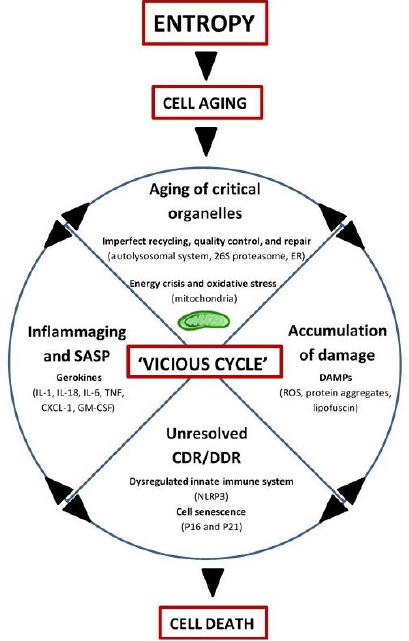
Figure 2. Integrated Systems Hypothesis of Aging (see text for details). DAMPs: danger-associated molecular patterns; ER: endoplasmic reticulum; CDR: cell danger response; DDR: DNA danger response; Inflammaging: chronic, low-grade inflammation with aging; SASP: senescence-associated secretory phenotype; Gerokines: cytokines, chemokines, growth factors, and proteases increased with aging; Vicious cycle: self-reinforcing feedback loop with detrimental outcome(s); NLRP3: inflammasome; P16: tumor suppressor protein P16 INK4A /CDKN2A; P21: tumor suppressor protein P21 Cip1 /CDKN1A; IL: interleukin; TNF: tumor necrosis factor; CXCL-1: chemokine (C-X-C motif) ligand 1 (also KC and GRO α ); GM-CSF: granulocyte-macrophage colony-stimulating factor.